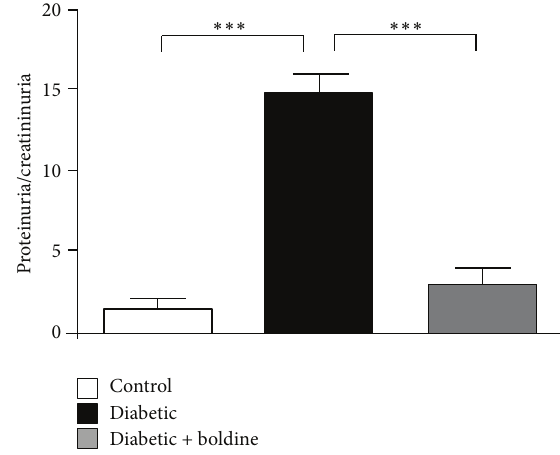
Figure 1: Boldine prevents kidney damage in diabetic rats. The graph shows the ratio of proteinuria/creatininuria in control (white bar), diabetic (black bar), and diabetic rats treated with 50 mg/Kg/day boldine (grey bar). Each bar represents the mean value ± SEM of 5 different animals. ∗∗∗ 𝑃 ≤ 0.001 , using the one- way ANOVA test followed by Bonferroni’s post hoc